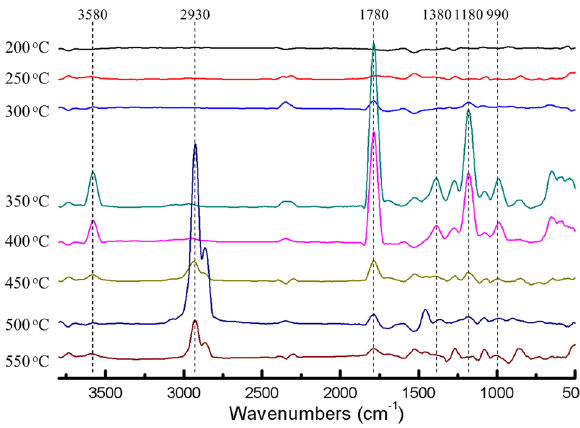
Figure 7: FTIR spectra during the thermal degradation process of